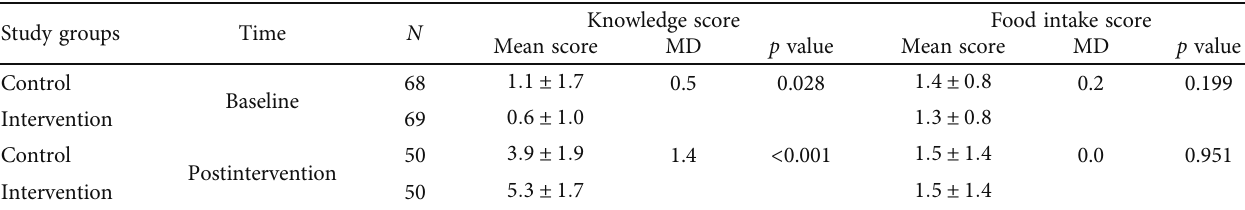
Table 7: Knowledge and iron-rich food intake scores before and after the intervention between the study